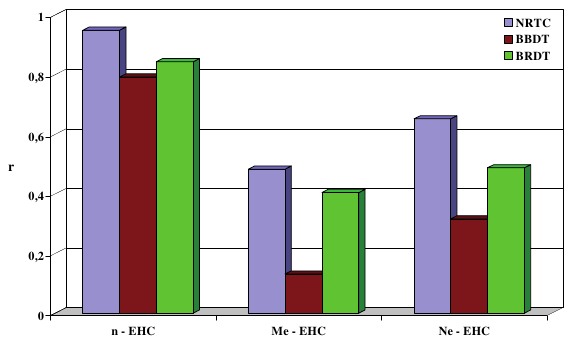
Fig. 19. The coefficient of Pearson’s linear correlation – r of hydrocarbons emission intensity with engine speed, torque and effective power